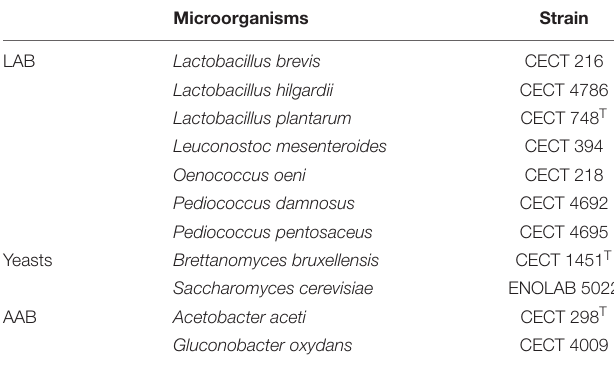
TABLE 1 | The strains used in this